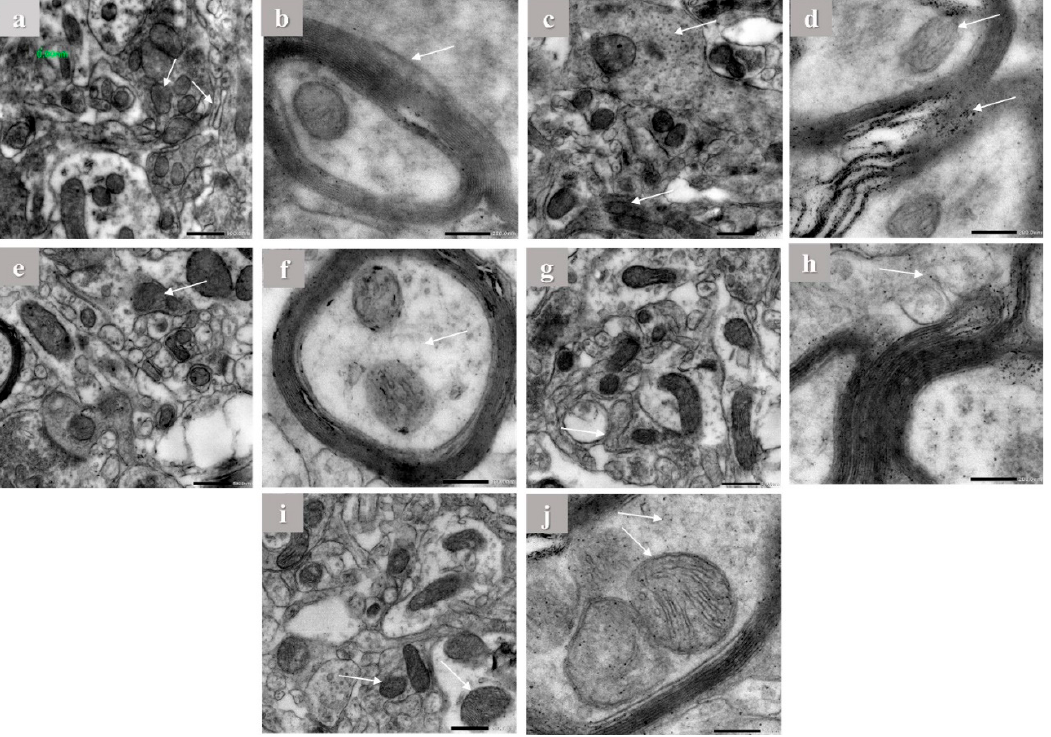
Figure 5. The electron microscope imaging of the brain hippocampus of Aricept-, gallic-, caffeine-, OPE 100-, and OPE 200-treated groups. Normal control group showed normal Golgi apparatus architecture without dilation ( a , b ), induced group showed amyloid beta deposition in myelin sheath ( c , d ), Aricept protective group showed concave synapse curvature and no amyloid beta deposition appeared ( e , f ), OPE 200 protective group showed asymmetric synapses with concave curvature and no amyloid beta deposition ( g , h ), and gallic acid protective group showed Golgi apparatus showed less dilation than induced group ( i , j ). Table 5. Effect of OPE on brain (hippocampus) mitochondrial length and width (nm) of different experimental rat groups treated with aluminum chloride.